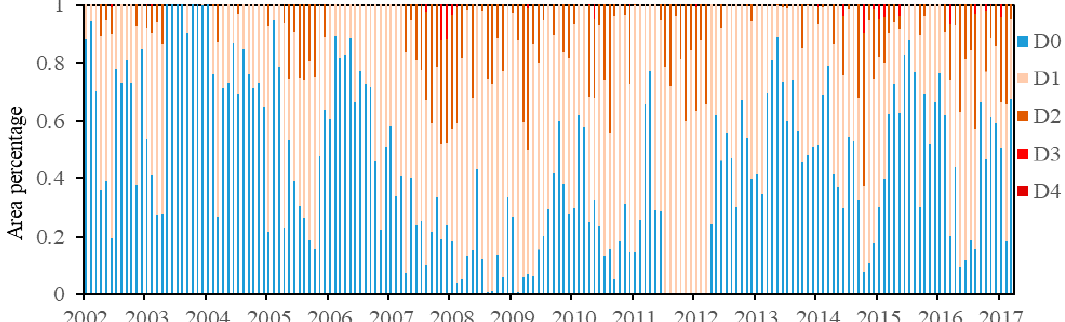
Figure 11. Percentage area of Mongolia subjected to droughts at different levels of severity based on WSDI from 2002 to 2017 (D0: no drought; D1: mild drought; D2: moderate drought; D3: severe drought; D4: extreme drought).